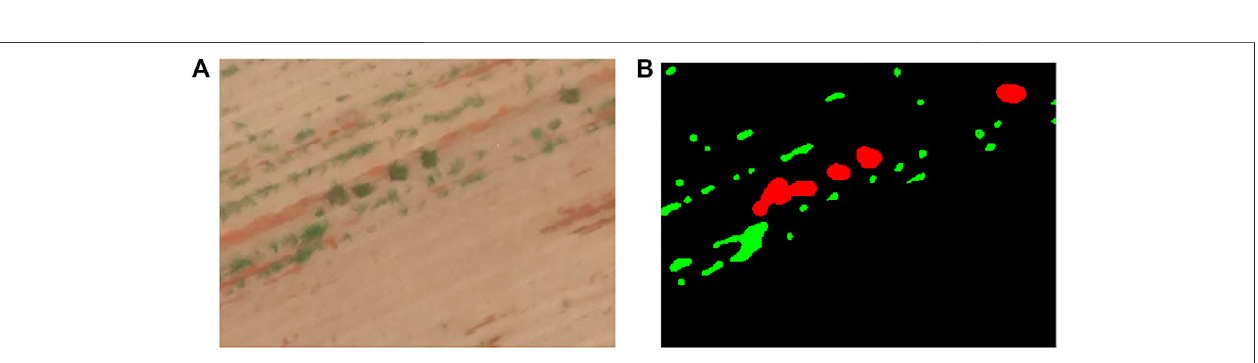
FIGURE 6 | Sample training images of sugarcane dataset. (A) training image; (B) annotated image.